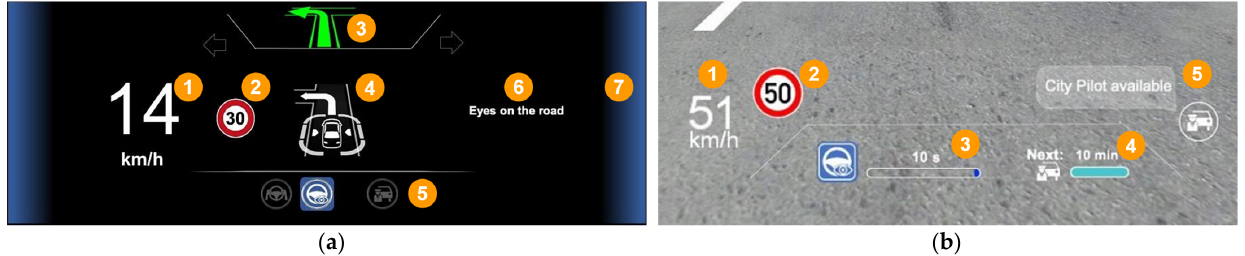
Figure 1. ( a ) IC with current speed (1), speed limit (2), navigation (3), maneuver (4), automation scale (5), L2-specific driver task (6), and level of automation color in the frame (7); ( b ) HUD with current speed (1), speed limit (2), predictive element for current (3) and upcoming segment (4), and availability pop-up message for City Pilot